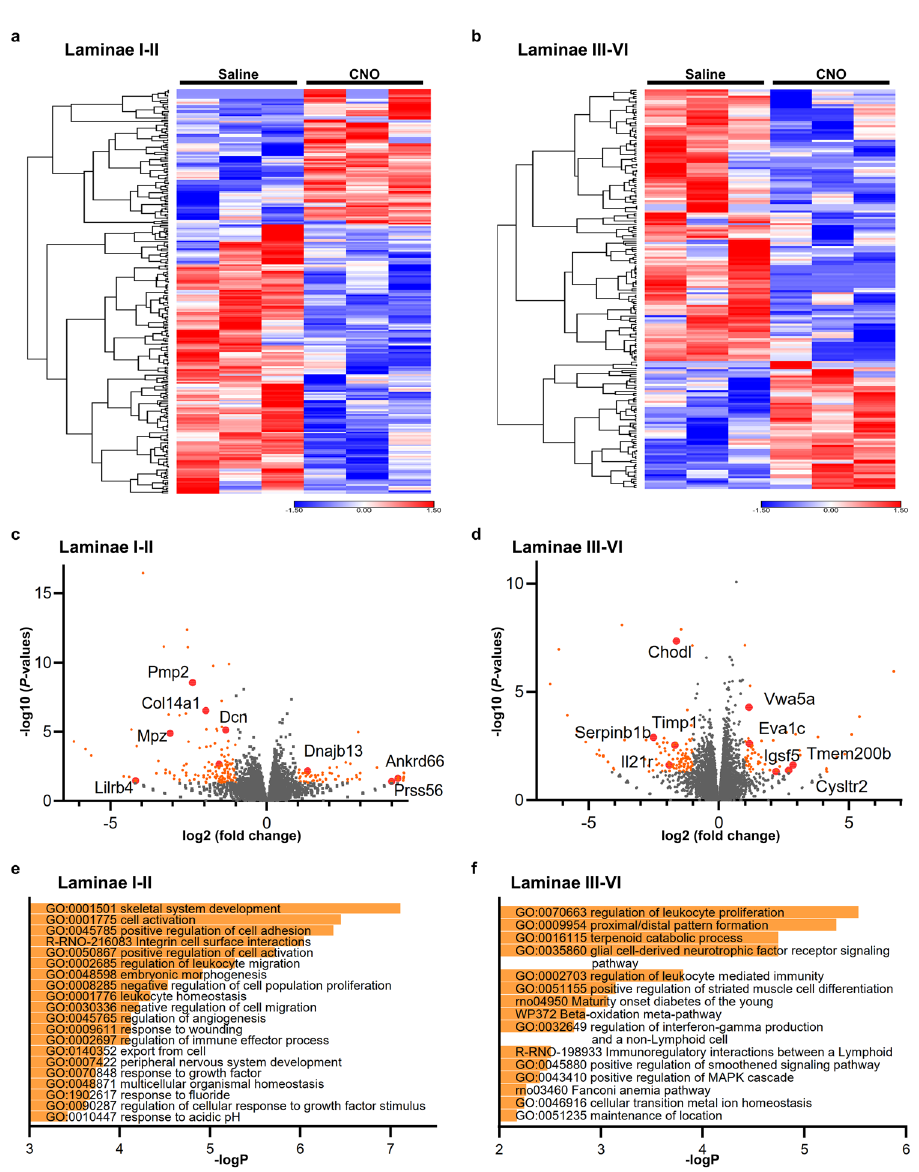
Fig. 5 OT induced differential gene expression in GABA-ergic neurons of the dorsal horn. Heat map of the altered genes in the laminae I – II ( a ) and laminae III – VI ( b ) of the spinal cord after the chemogenetic activation of endogenous OT by using RNAseq. The samples for the analysis were collected at 120 min after the s.c. injection of Saline or CNO (1 mg kg − 1 ). Scale represents normalized values subtracted by row mean divided by standard deviation. Volcano plot of the genes in the laminae I – II ( c ) and laminae III – VI ( d) of the spinal cord. The genes that were signi fi cantly altered were depicted by orange color dots. Red-colored dots indicate subset of the genes that are predominantly expressed in GABA-ergic neurons. Gene ontology (GO) terms that were enriched by endogenous OT in the laminae I – II ( e ) and laminae III – VI ( f ) of the spinal cord. Raw RNA sequencing data are available at Gene Expression Omnibus (GEO) in the National Center for Biotechnology Information (NCBI) (accession number GSE210528). See also Supplementary Figs. 5,